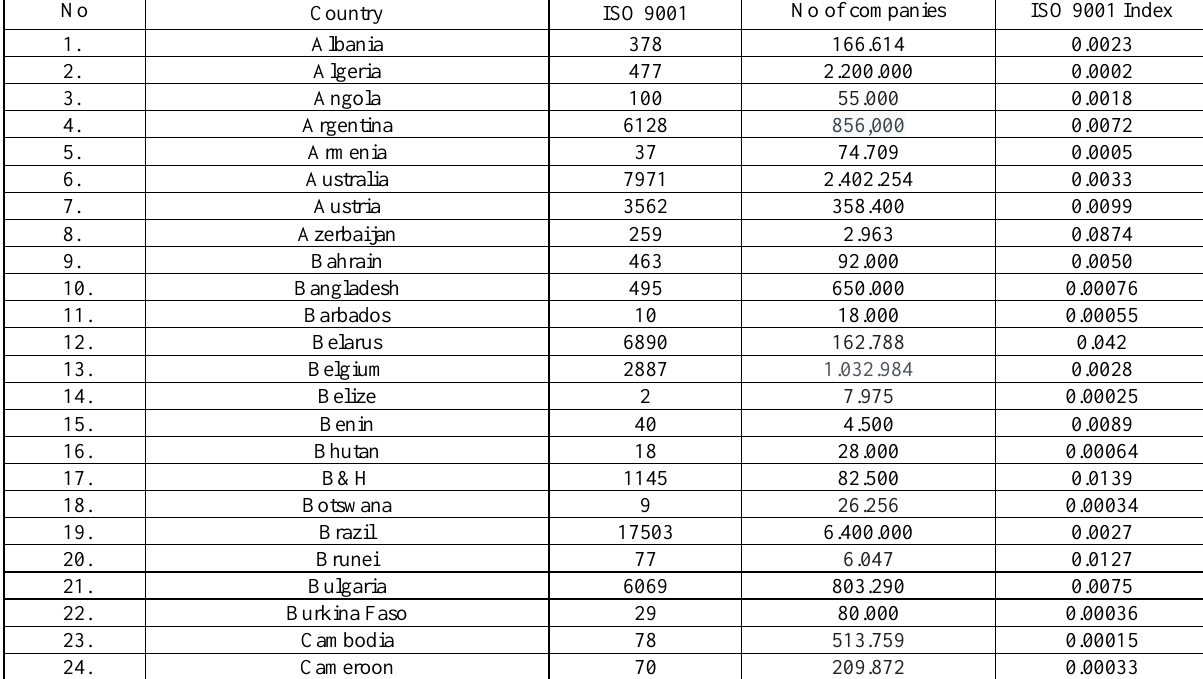
Table 1. List of countries for ISO 9001 certificates issued in alphabetic order (taken from ISO), number of businesses per country (taken from HitHorizon), and ISO 9001 index per country (136 countries